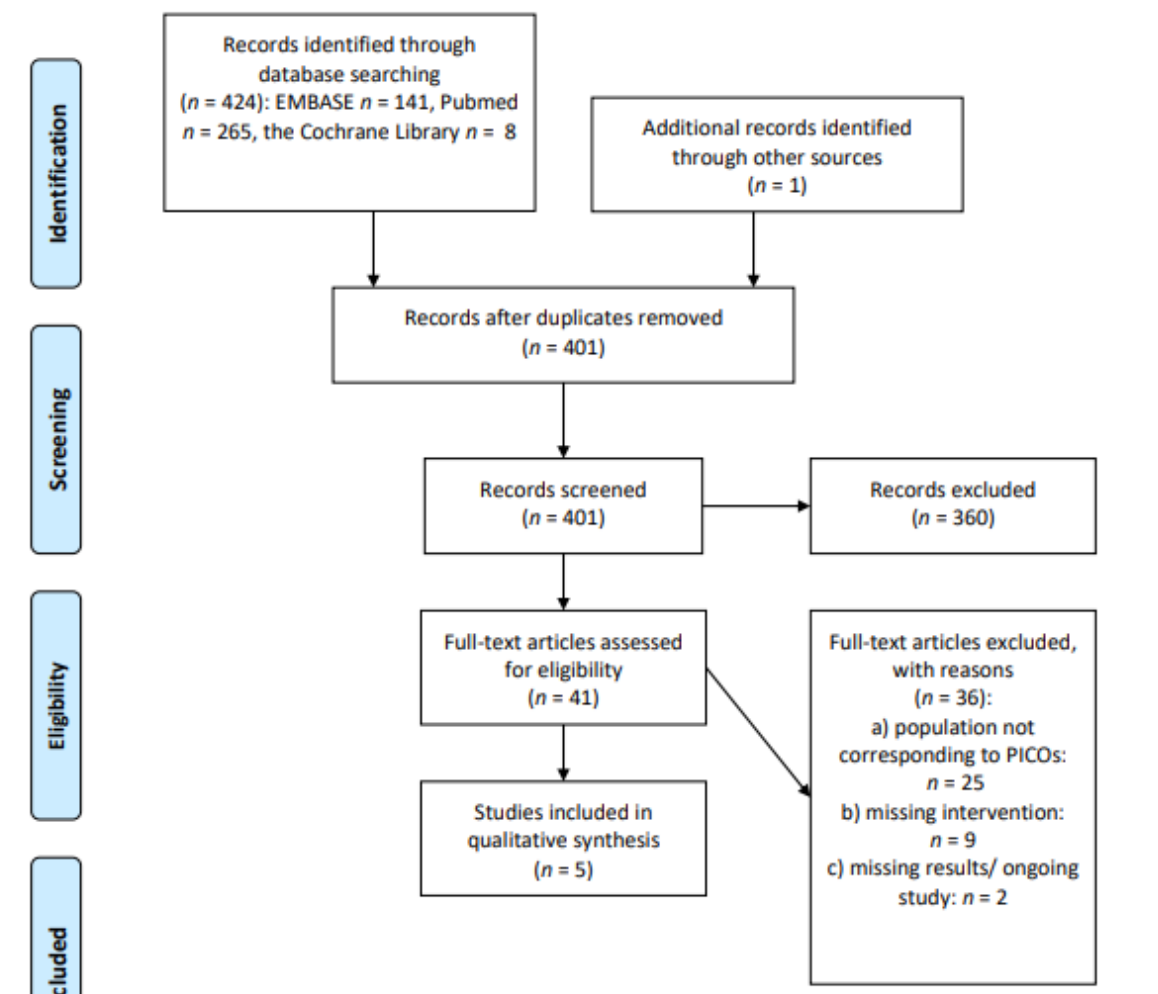
Figure 1. PRISMA flow-chart on physical activity/exercise.